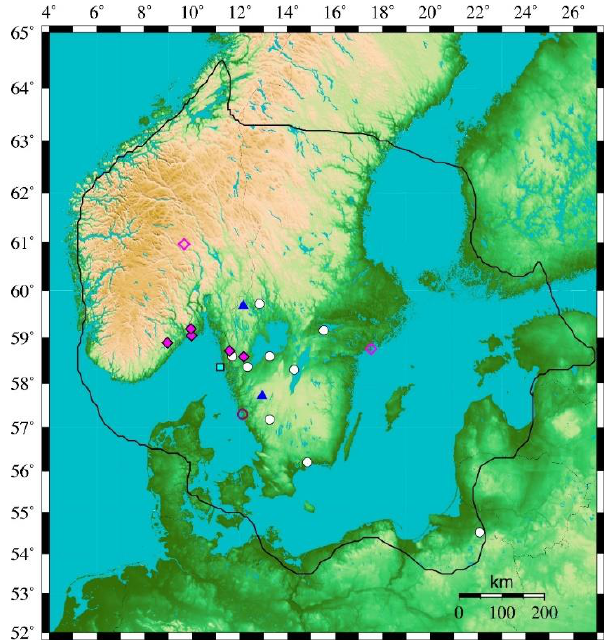
Figure 4. Earthquake environmental effects related to the earthquake of 23 October 1904 (the white circles mark sites of water turbulence and the open circle a site of reportedly calm water, while the square marks land subsidence, the purple diamonds mark landslides and rockfalls, the open diamonds mark debatable landslides, the blue triangles mark ground moving in waves, and the solid line marks the area of perceptibility as outlined in 1913 [33]).